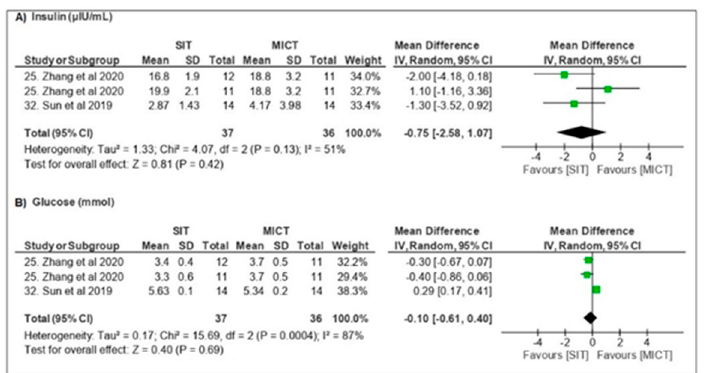
Figure 6. Forest plot of the effects of SIT vs. MICT intervention on outcomes: ( A ) insulin and ( B ) glucose; SIT: supramaximal intervals; MICT: moderate intensity continuous training; IV—inverse of the variance; CI: confidence interval; SD: standard